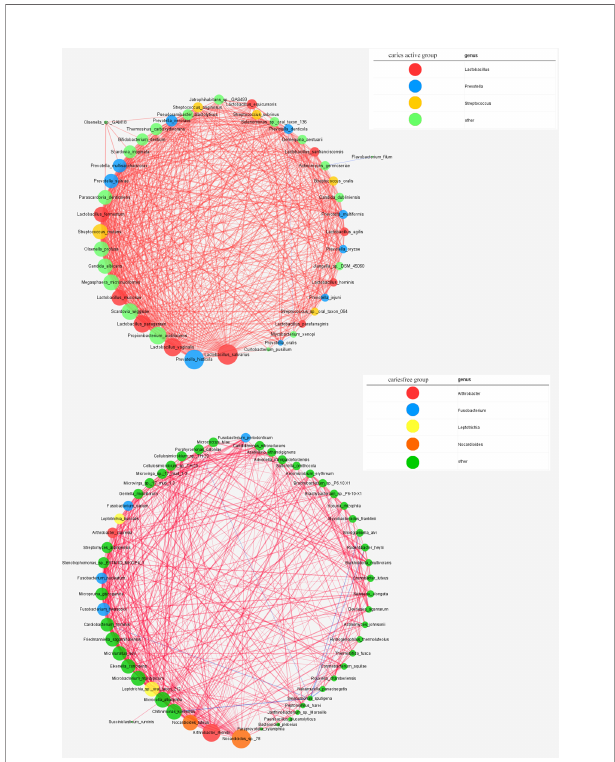
FIGURE 7 | Networks indental microbial communities under caries-active and caries free status are shown, with each microbial species and cooccurrence relationship indicatedby a nodeandan edge, respectively. A connection (line between dots)indicates a strong (Spearman ’ s p >0.6) and signi fi cant (p< 0.05) correlation.The size of each nodeisproportional to therelative abundance. Lines between nodes indicate positive correlations(red)ornegative correlations(blue). The top thress abundant genera are indicated in